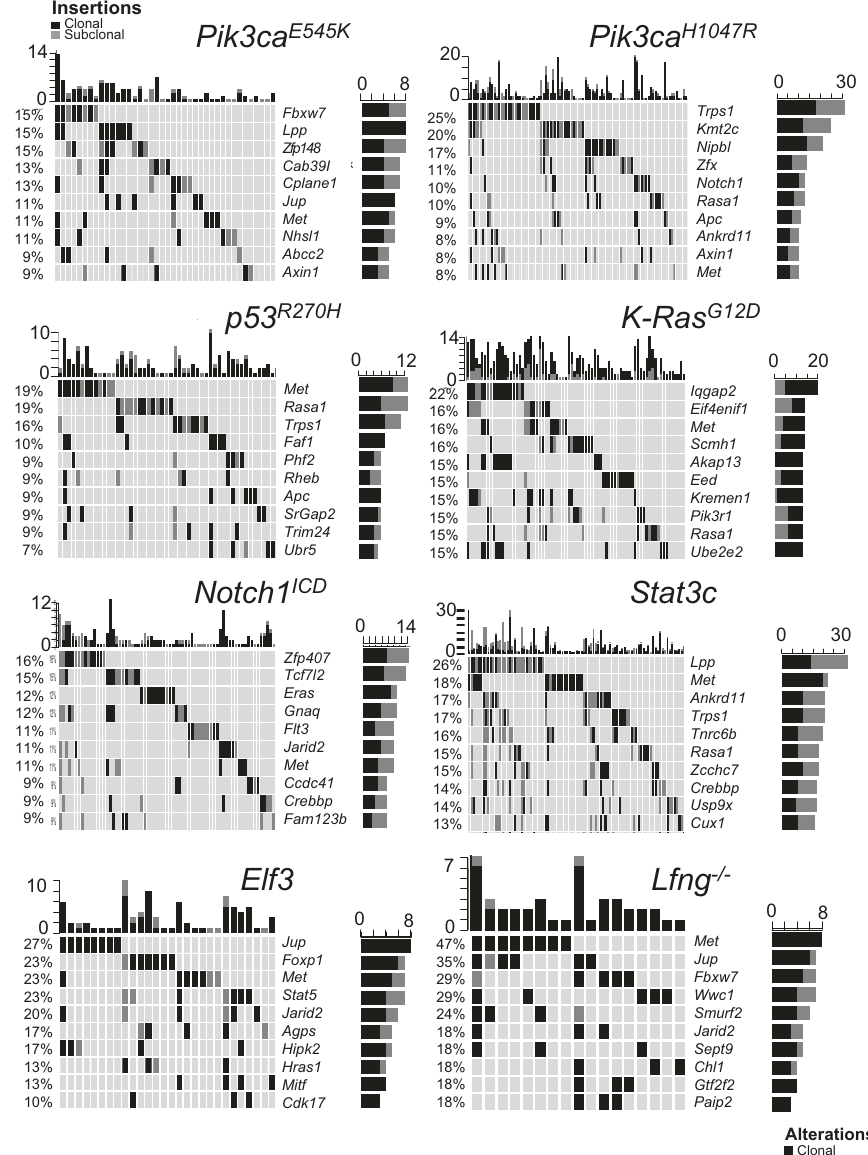
Fig. 1 Top common insertion sites for Sleeping Beauty in tumors from distinct GEMM models of breast cancer. Overview of clonal/subclonal gCIS from GEMM-based SB screens as indicated. Top 10 gCIS are shown for each. Note, the percentage of tumors with each gene targeted by SB is shown on the y-axis to the left for each bar graph, the number of tumors with clonal vs. subclonal SB targeting by SB is shown on the y -axis to the right, whereas the number of identi fi ed gCIS in each tumor is shown on the x -axis above each bar